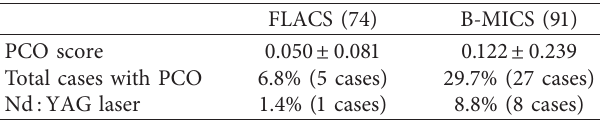
Table 3: PCO score and percentage of PCO cases and YAG laser in the two